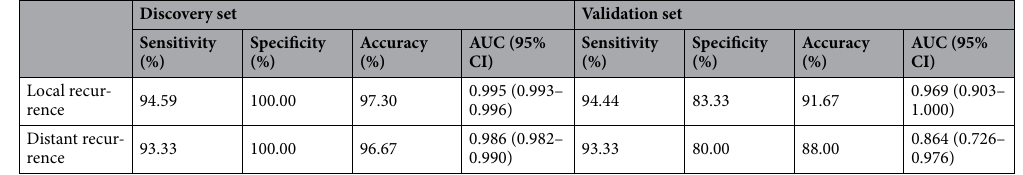
Table 2. Diagnostic performance of the prediction model for each recurrence pattern: discovery and validation set. Discovery and validation set was randomly split the total dataset ( n = 192) into 8:2 ratio. AUC area under the curve, CI confidence interval.